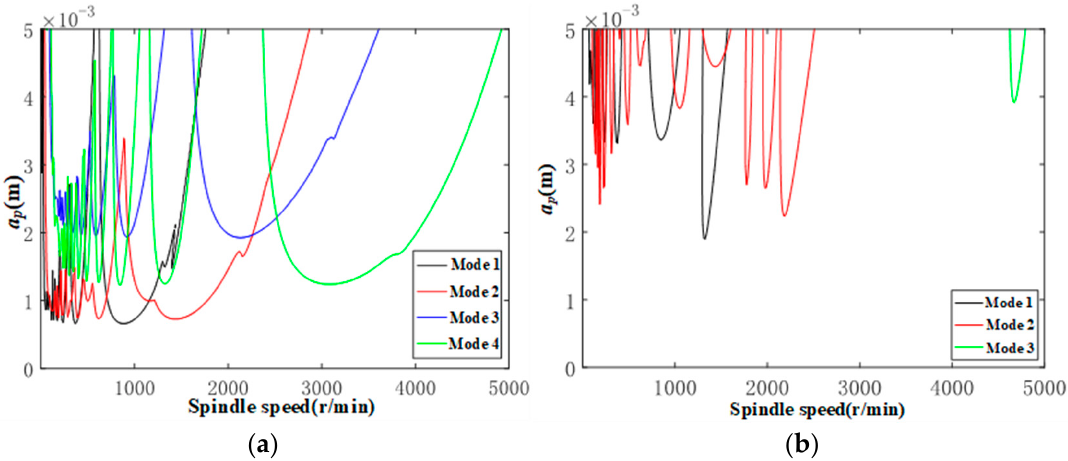
Figure 17. Stability lobes of initial position for ordinary helical milling cutter and step-cutter. ( a ) Ordinary helical milling cutter. ( b ) Step-cutter.